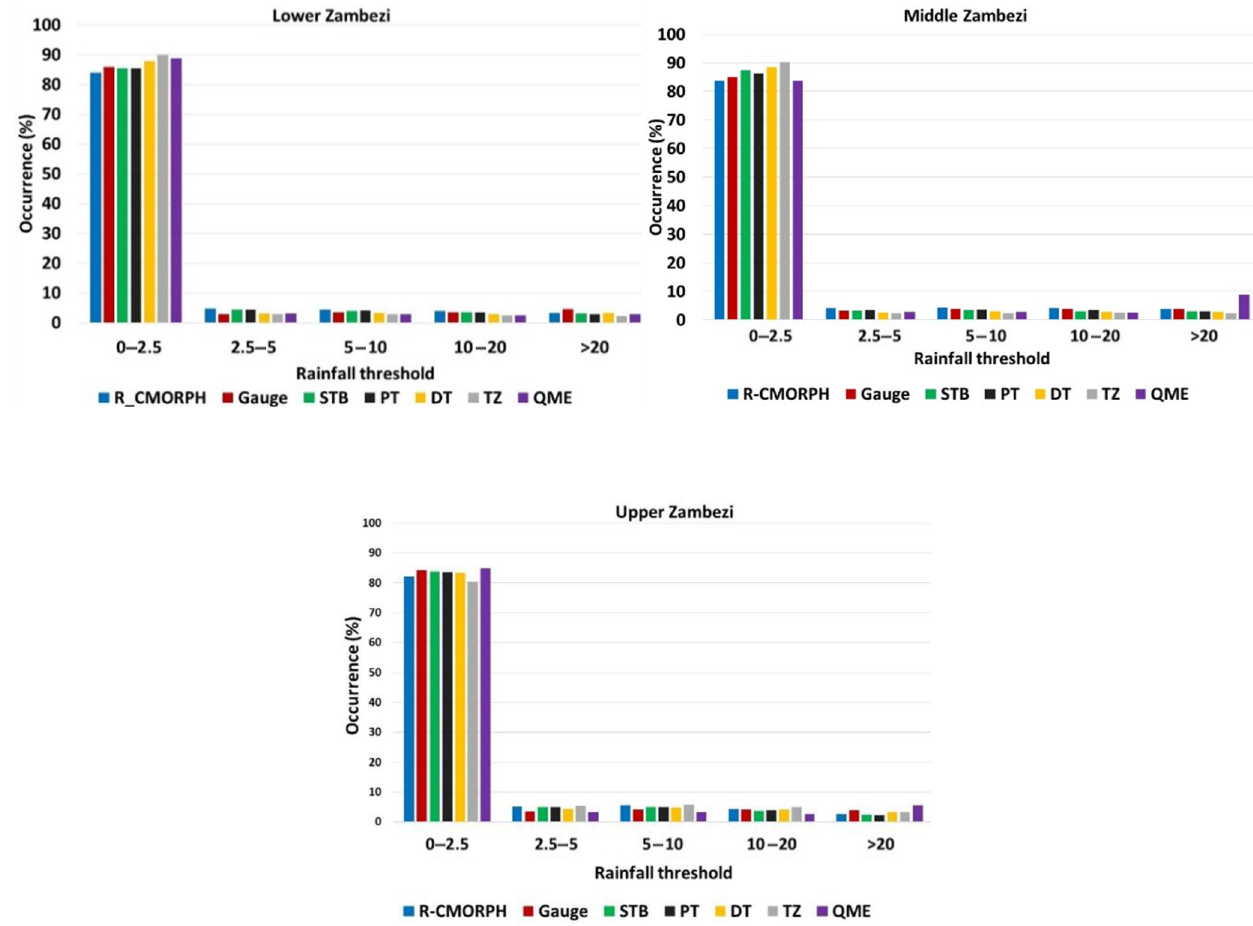
Figure 8. Percentage occurrence for rainfall rate classes.